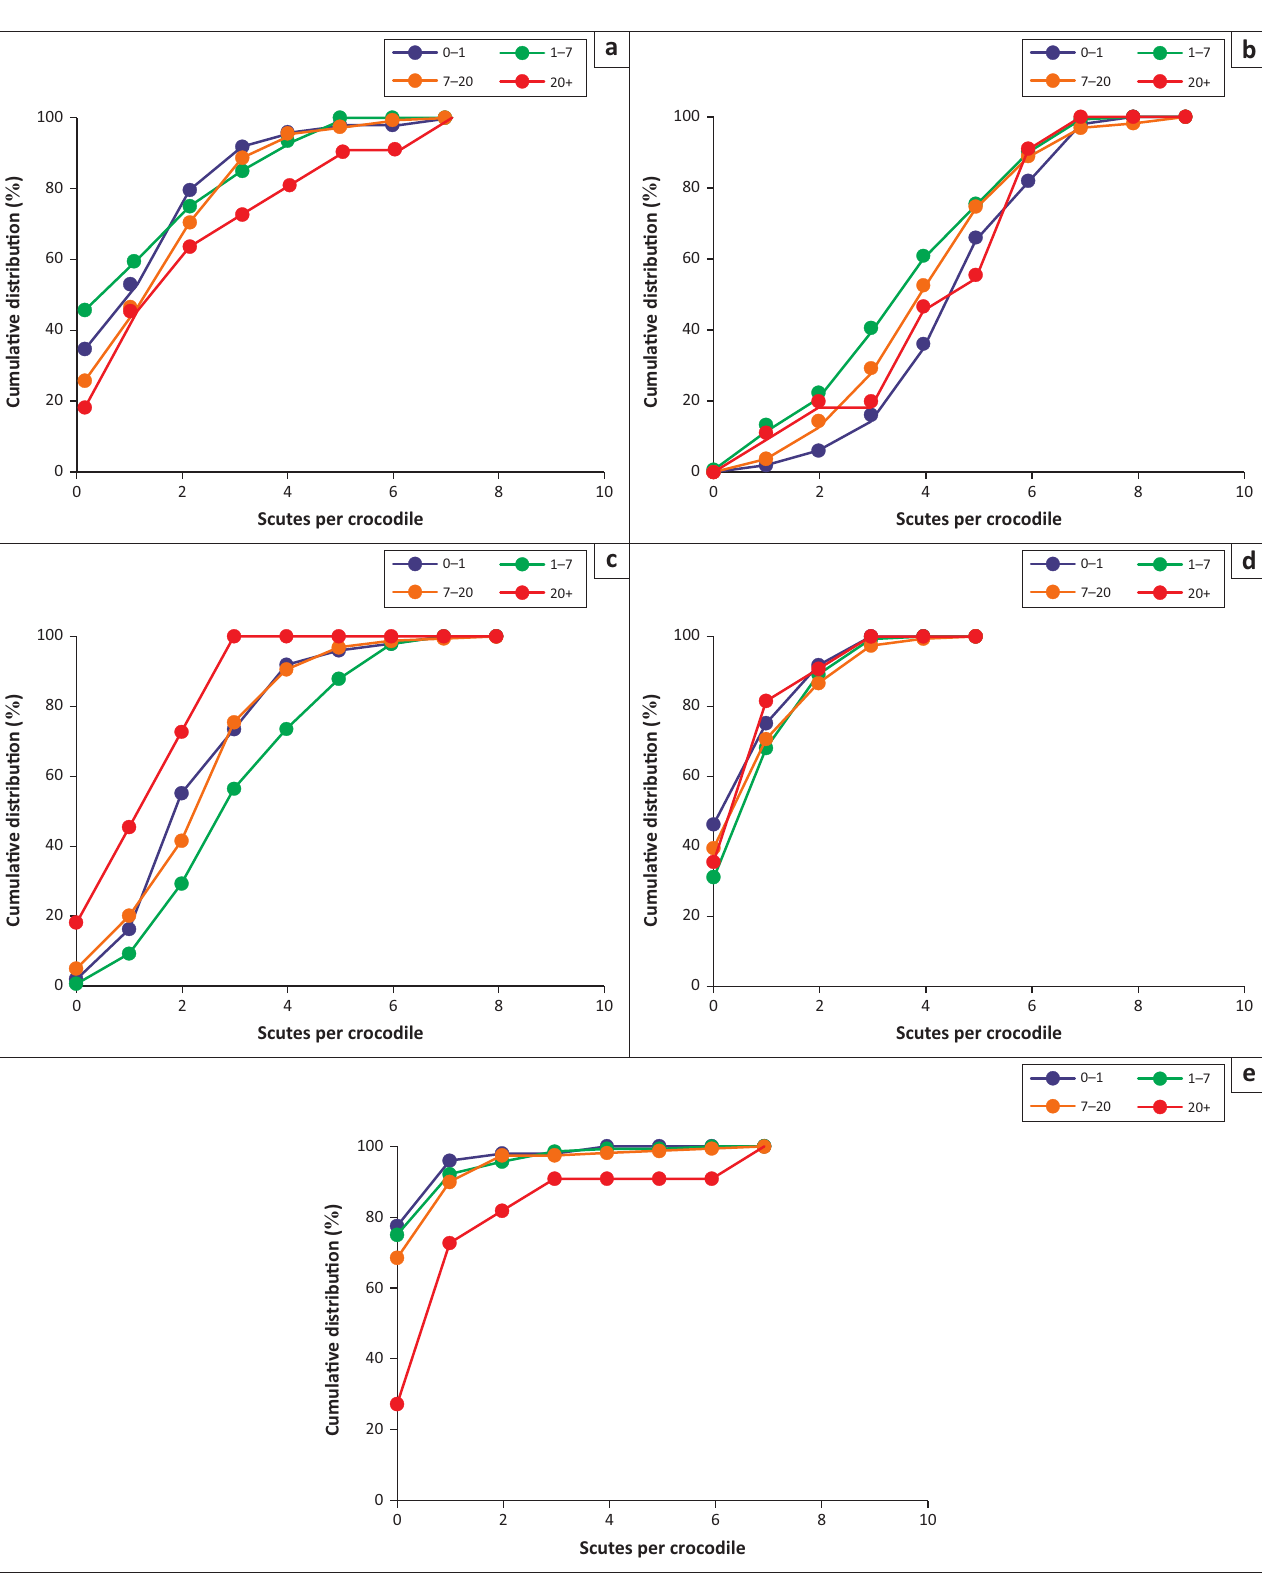
FIGURE 2: Cumulative distribution of scute colouration per crocodile age group. (a) Cumulative distribution of light/white-coloured scutes per crocodile age group. (b) Cumulative distribution of scutes that are less than 50 % dark/black per age group. (c) Cumulative distribution of scutes that are more than 50 % dark/black per age group. (d) Cumulative distribution of scutes that are completely dark/black per age group. (e) Cumulative distribution of missing scutes per age